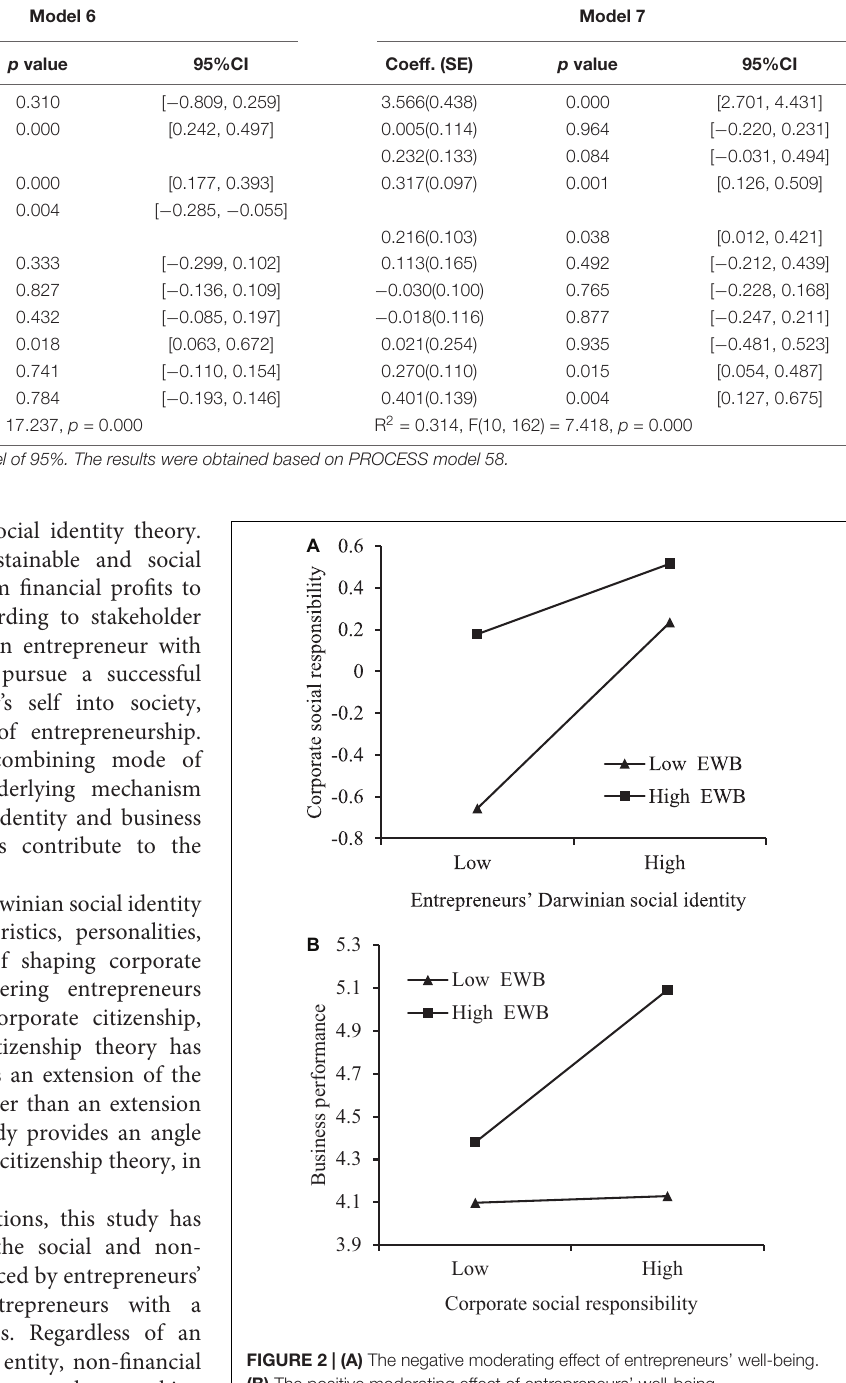
sacrifice their claimed social responsibilities. Considering the circumstance where stress for material pursuits dominate, it